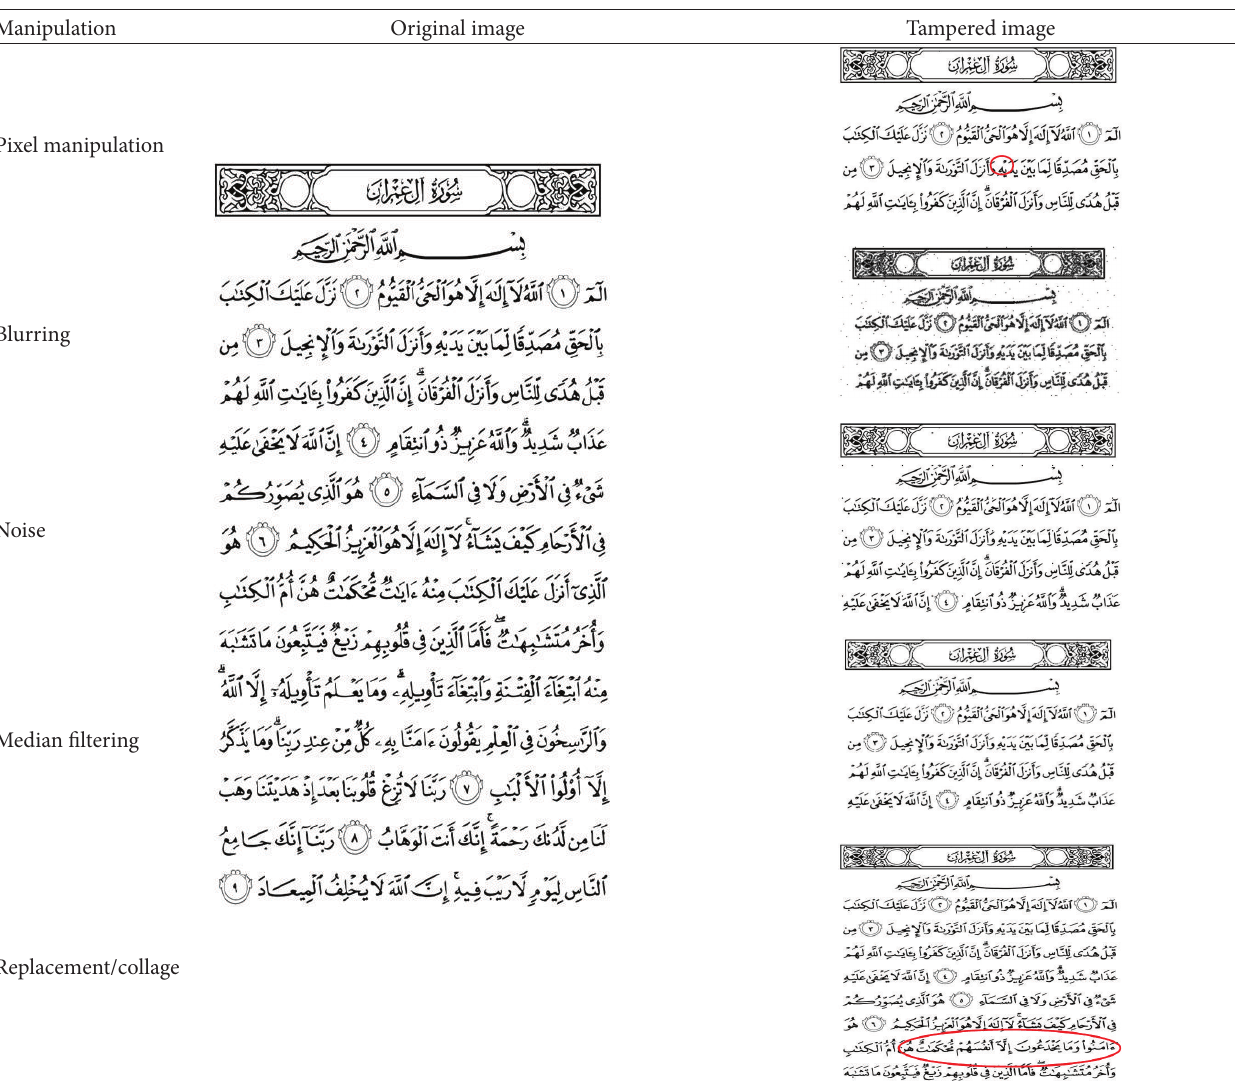
Table 5: Examples of image manipulations on page-050.png.